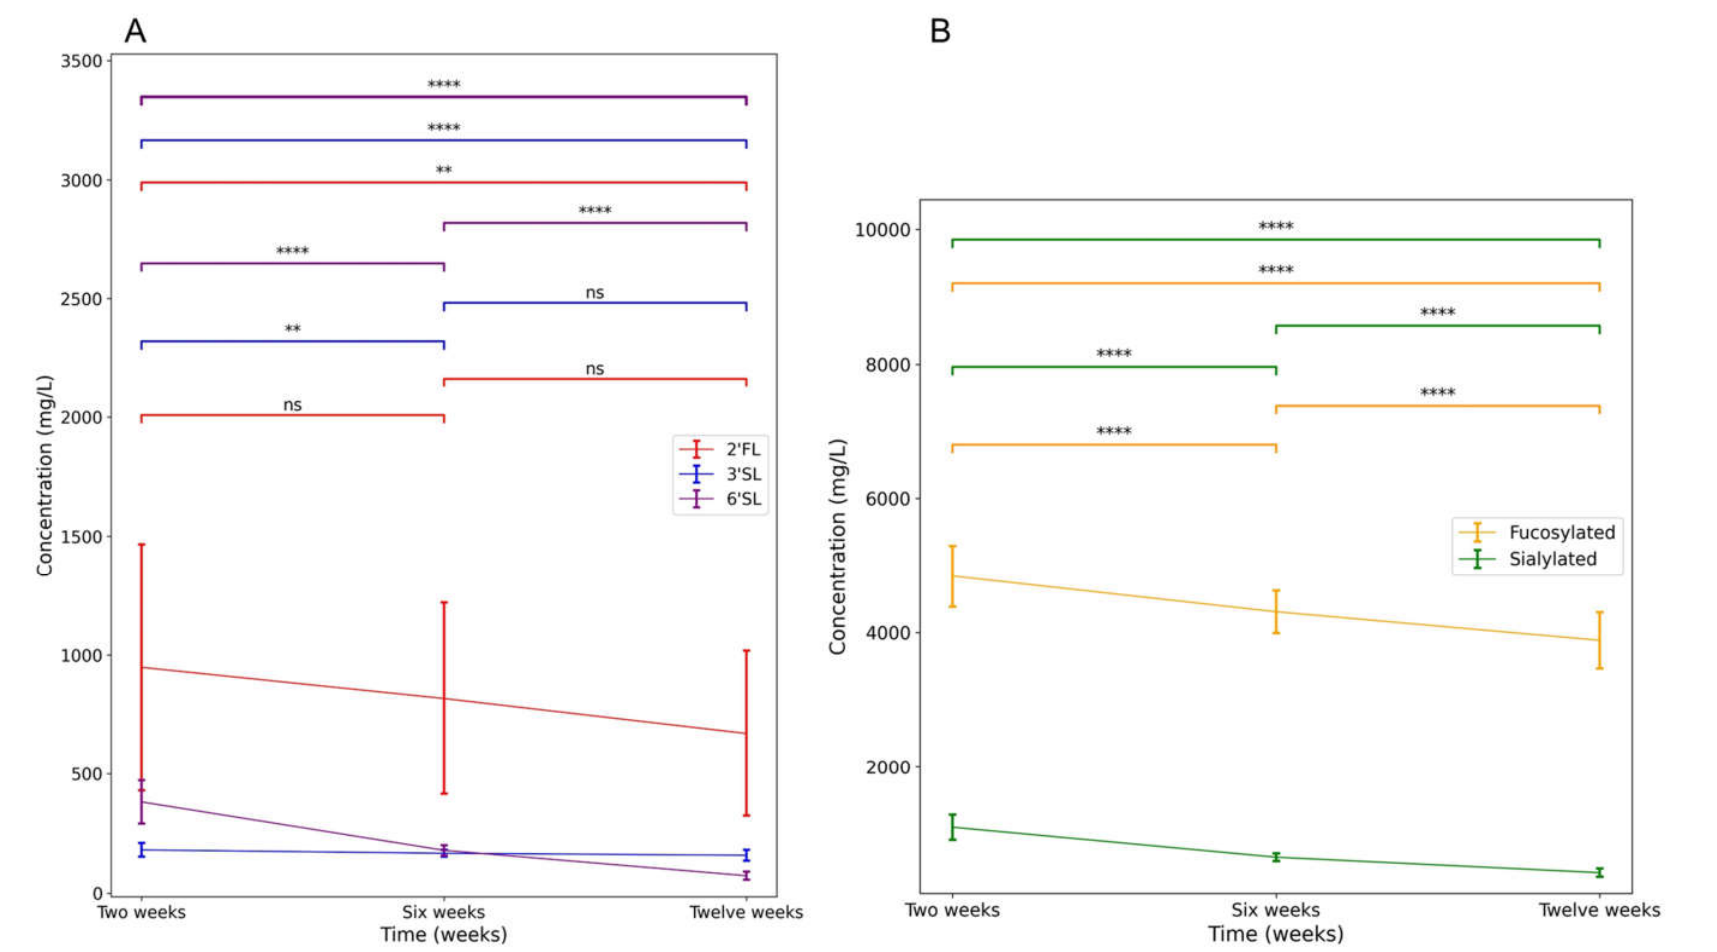
Figure 3. Change in HMO concentrations over the first three months. ( A ) shows the change of individual HMO concentrations. ( B ) shows the change of grouped HMO concentrations. Error bars represent 1 SD of the mean. ns: non-significant; ** p < 0.01, **** p < 0.0001.